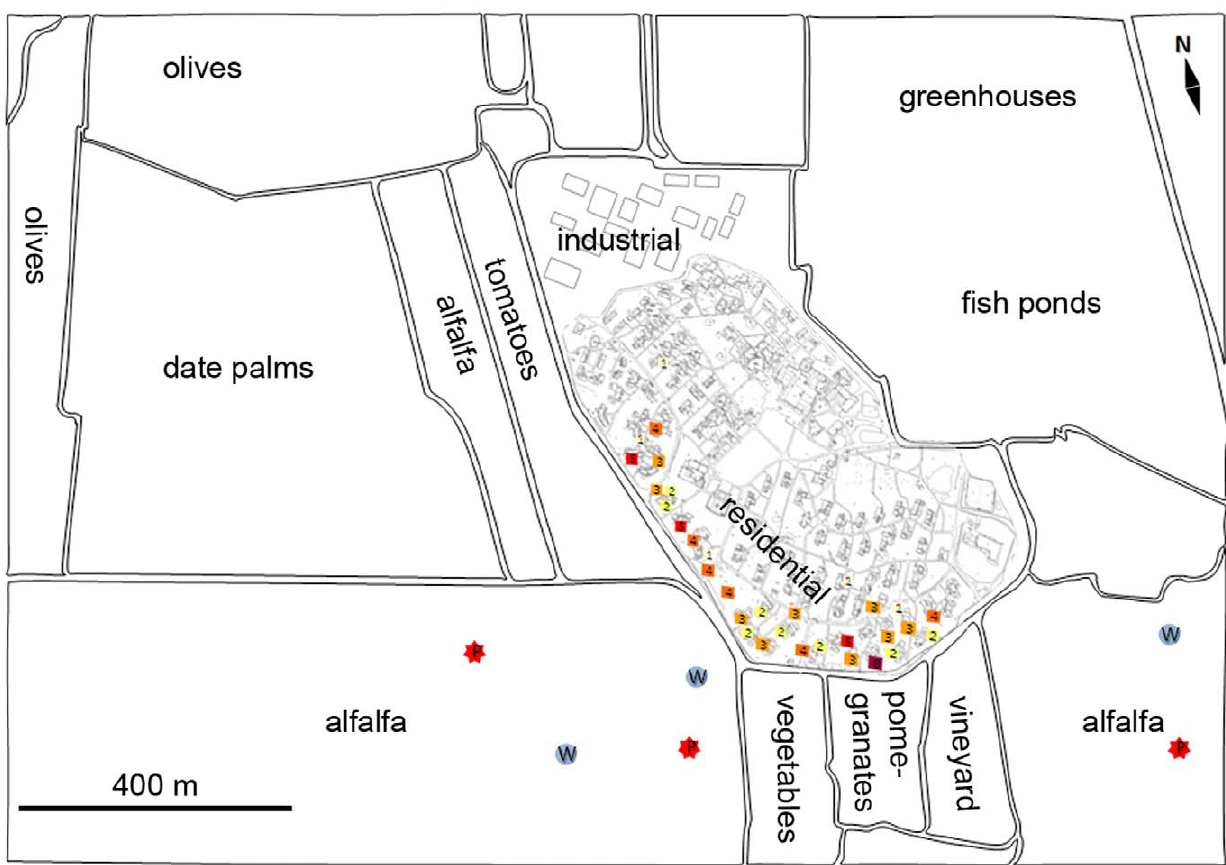
Figure 1. Annotated map of Sde Eliyahu and vicinity showing inhabited areas of the Kibbutz and the surrounding agricultural areas. Houses where CL cases reside are marked with colored squares. The number of cases appears in each square and a darker color denotes more cases. The approximate location of different cultivars is marked and type of cultivar noted. The letter P in a red star denotes alfalfa fields where voles were captured by plowing, while a blue circle containing a W denotes the approximate location where voles were captured by flooding.